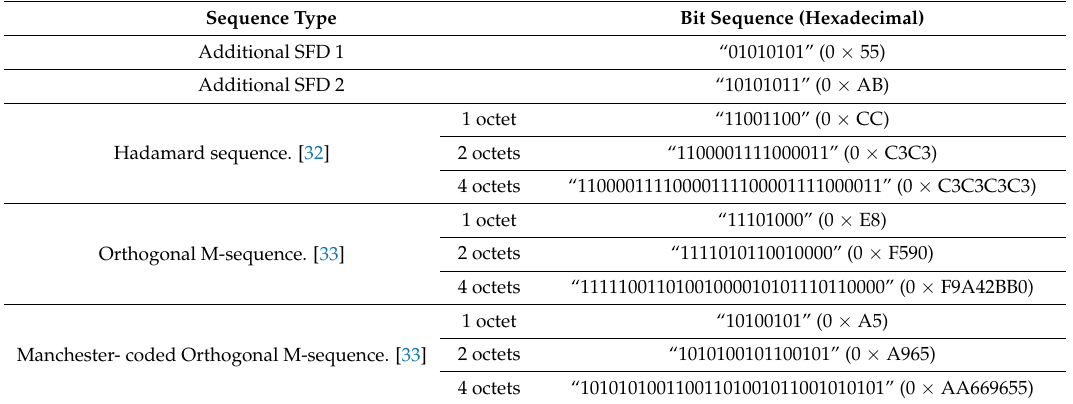
Table 3. SFD used in computer